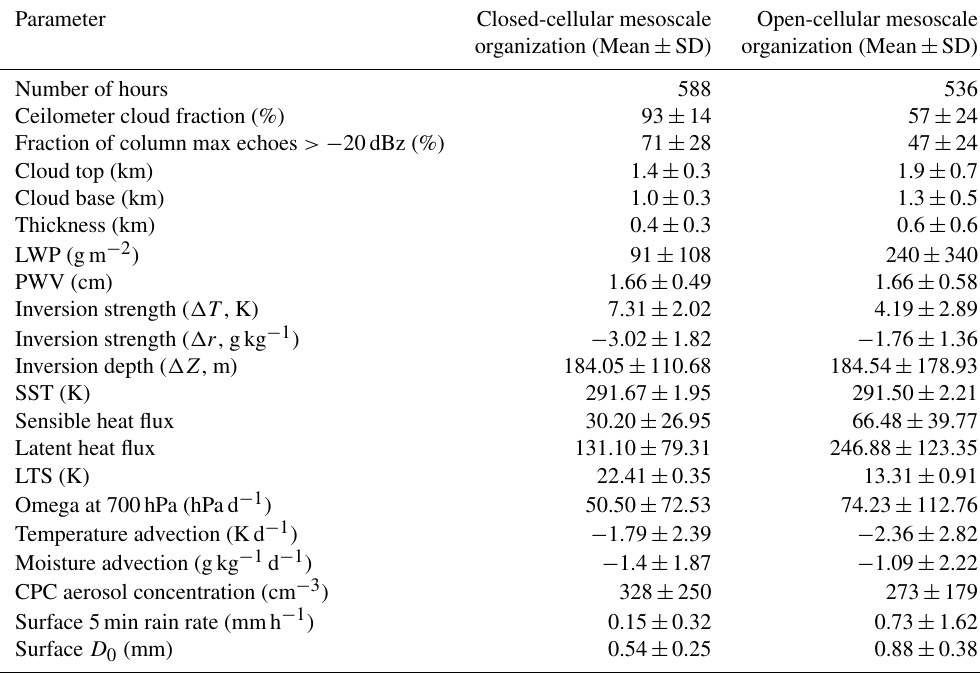
Table 3. Mean and standard deviations of important bulk parameters during closed- and open-cellular conditions.